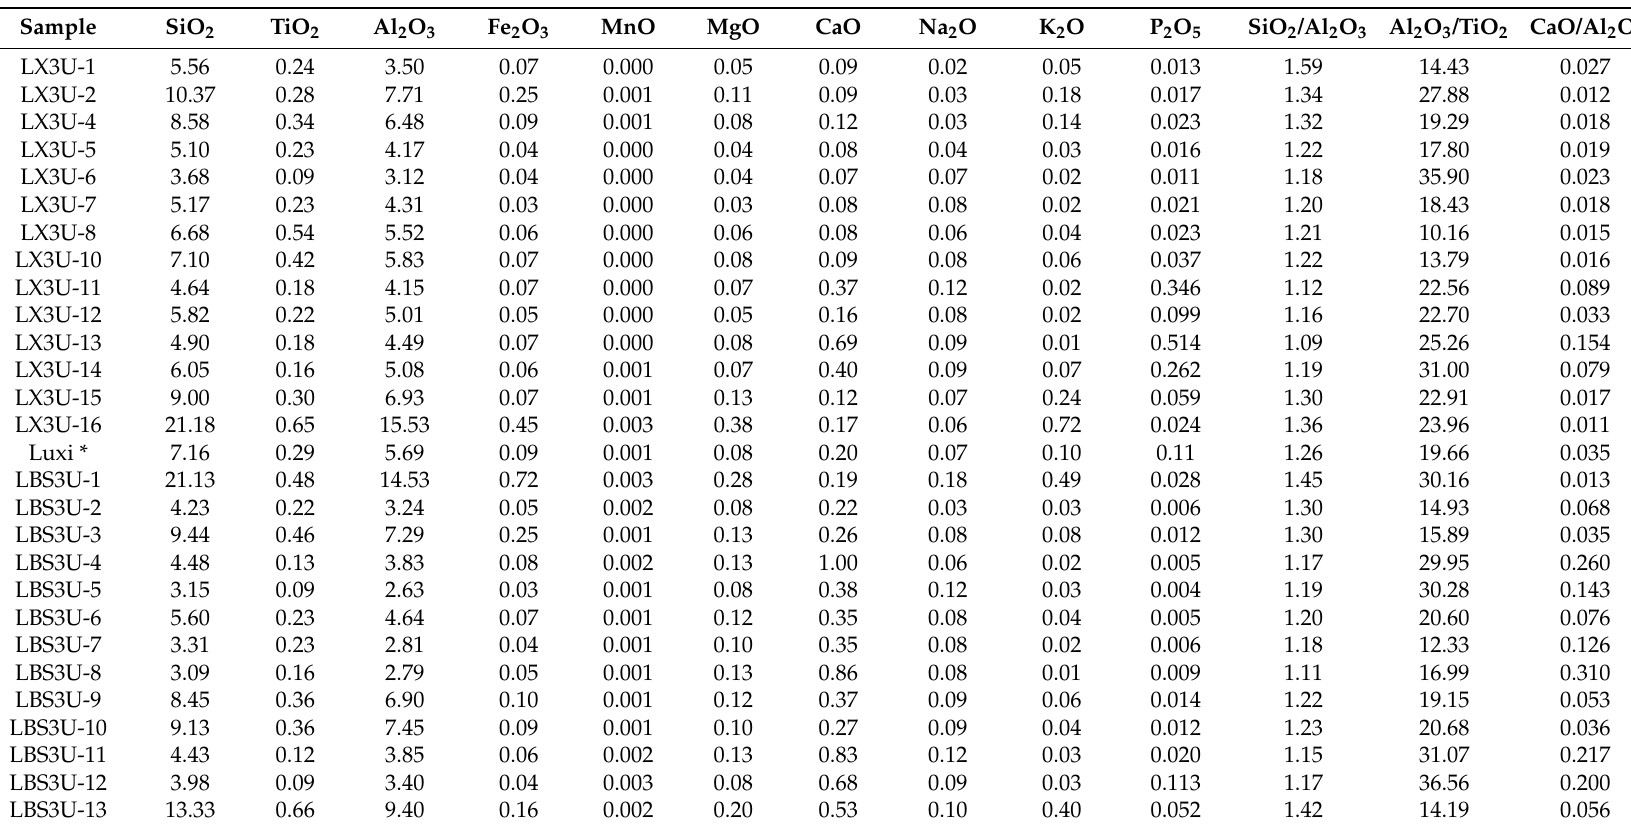
Table 3. Major element contents (%), the ratios of SiO 2 /Al 2 O 3 , CaO/Al 2 O 3 , and Al 2 O 3 /TiO 2 in the Upper No. 3 coals from the Luxi, Liangbaosi, and Tangkou mines, southwestern Shandong, China